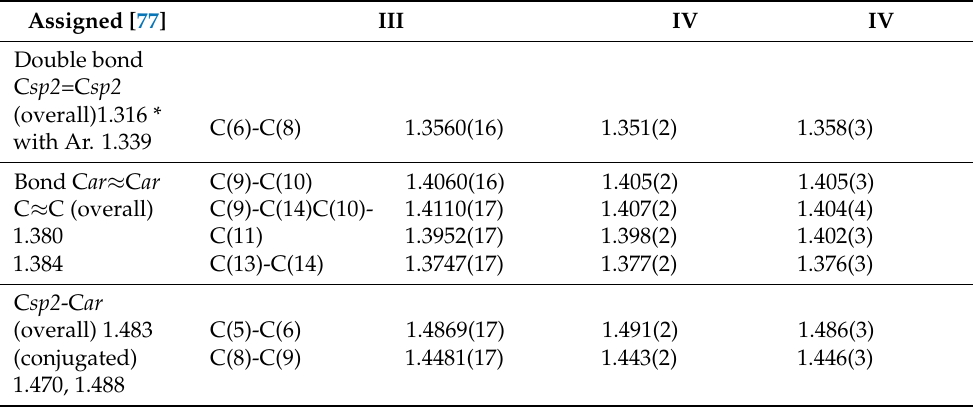
C sp2 -C ar (overall) 1.483 * when conjugated.